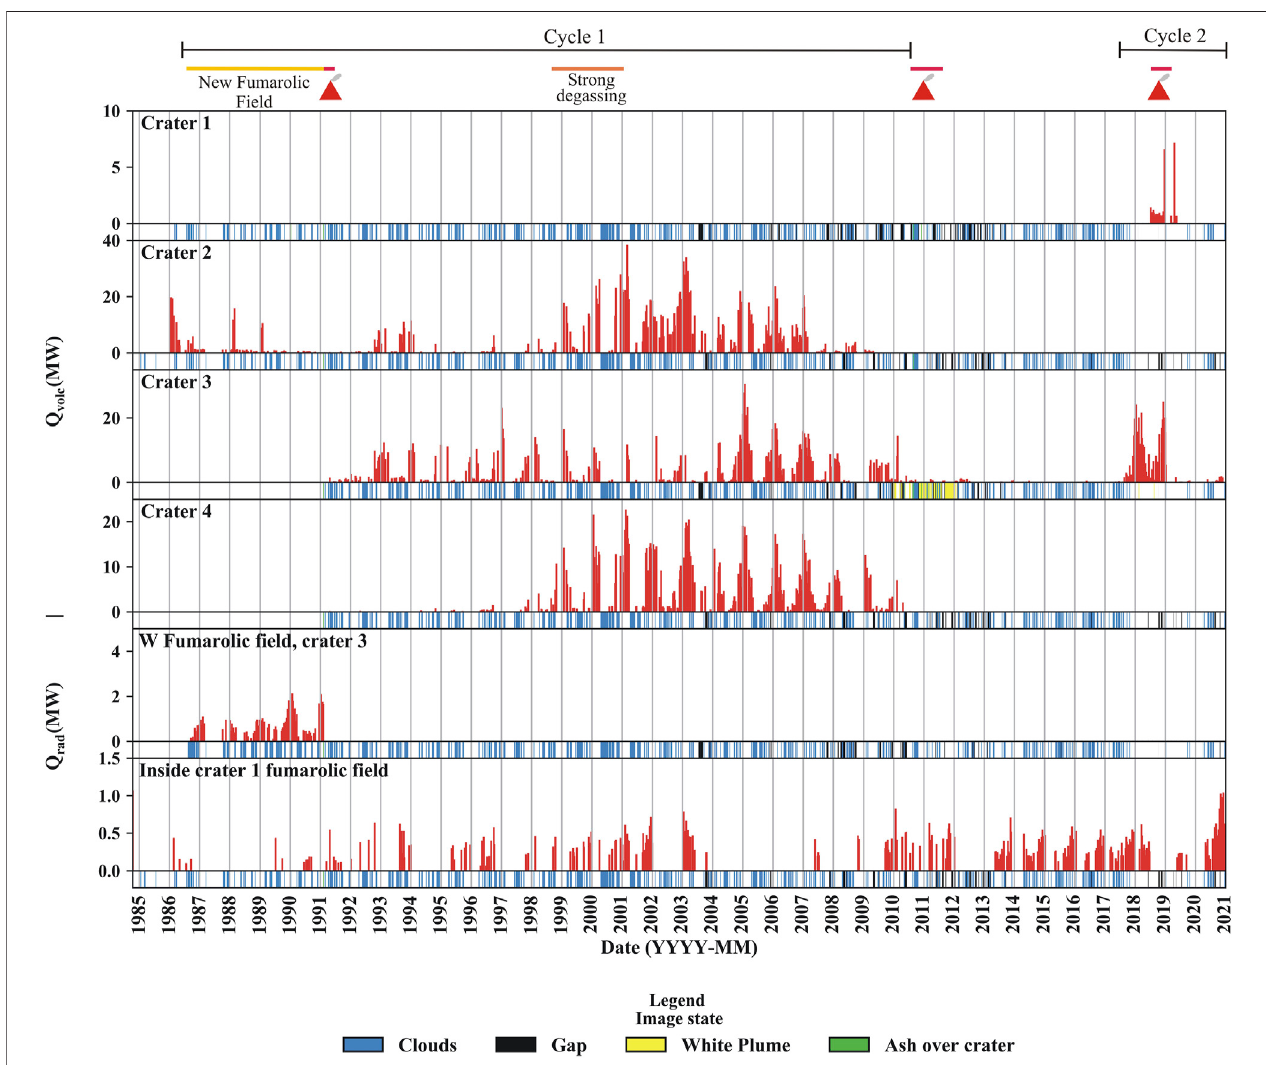
FIGURE5| Q volc andQ rad inMWvs. date(YYYY-MM)isshown forCraterLakes1,2,3,and4,and forthenewfumarolic fi eldinthecurrentpositionofCrater3and Crater1fumarolic fi eld,respectively.Themajorevolutivecyclesanderuptiveactivityareshownintheupperpart.Redlinesaccompaniedbyredvolcanoindicatevolcanic unrest periods, yellow line the presence of a new fumarolic fi eld, and orange line the strong degassing process. The secondary graphics at the base of Q volc and Q rad graphics showed the state of the satellite images, corresponding to free clouds images (white area), presence of clouds (light blue area), gas plume (yellow area), and ash (green area) over crater lakes. Vertical grey lines correspond to an annual